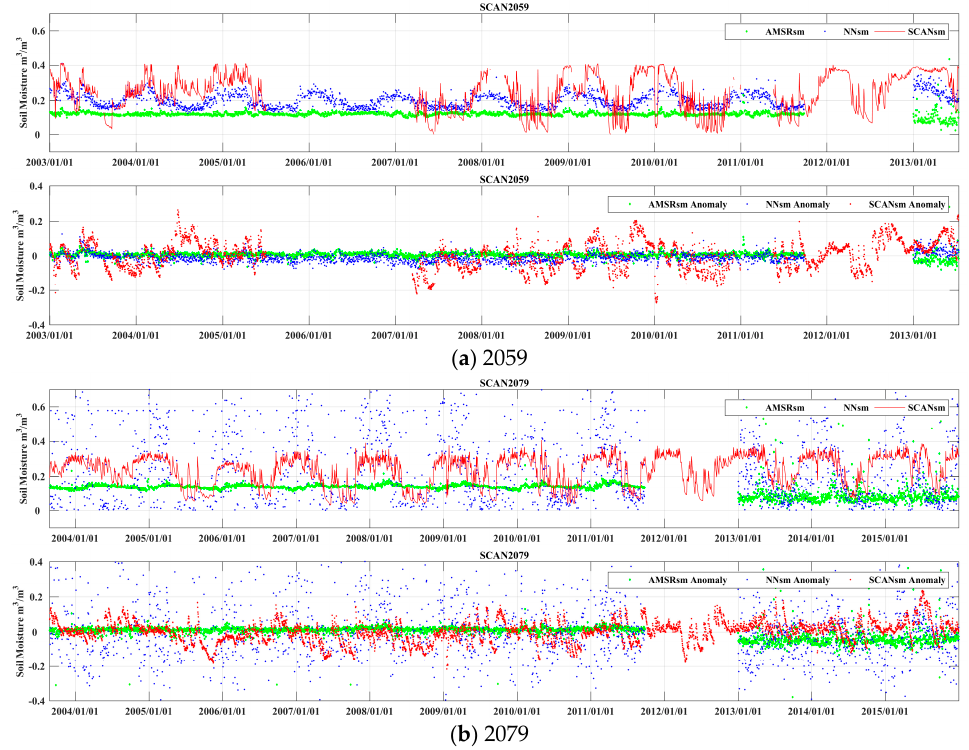
Figure 7. Time series (upper panel) and anomaly time series (lower panel) for SCANsm (red line), NNsm (blue dots) and AMSRsm (green diamonds) over the long time period (2003–2015) in sites: ( a ) 2059 and ( b ) 2079.